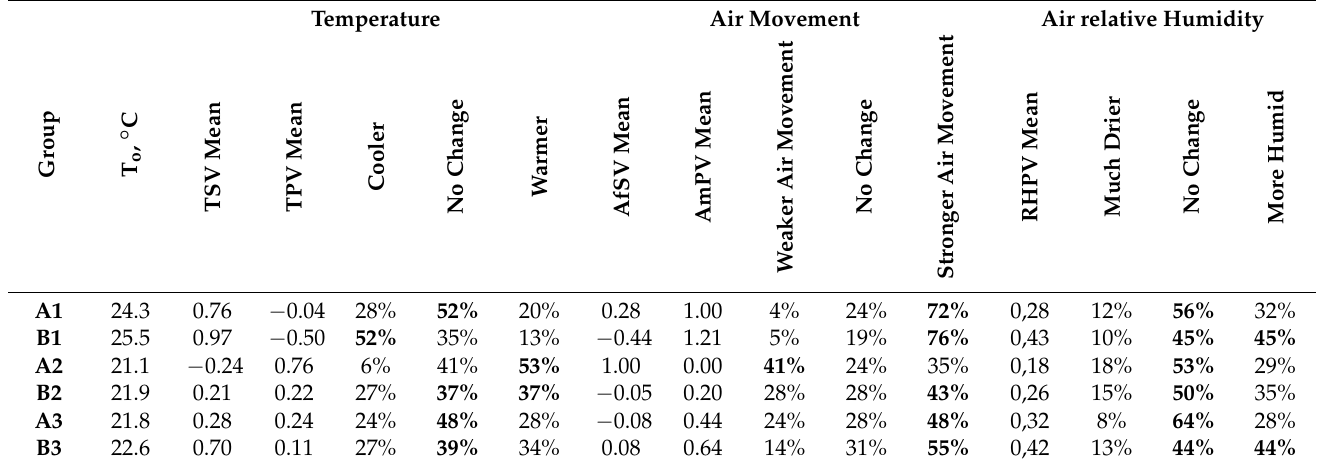
Table 5. Summary of students’ responses.